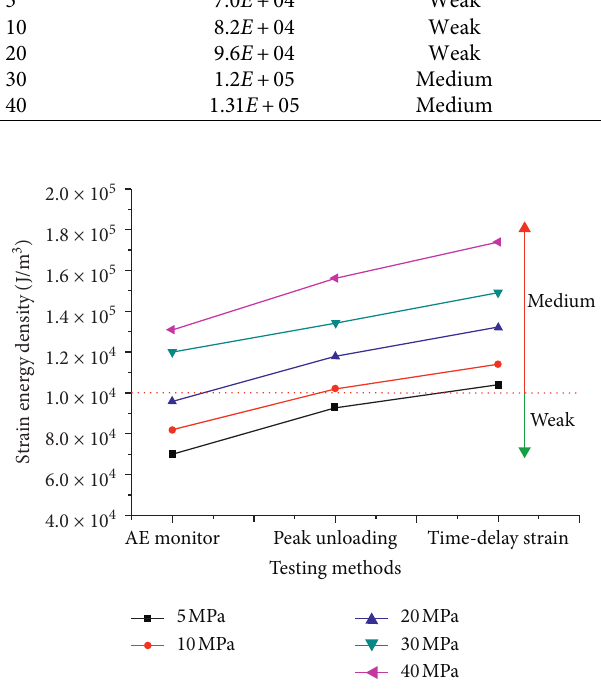
Figure 12: Strain energy and rockburst tendency